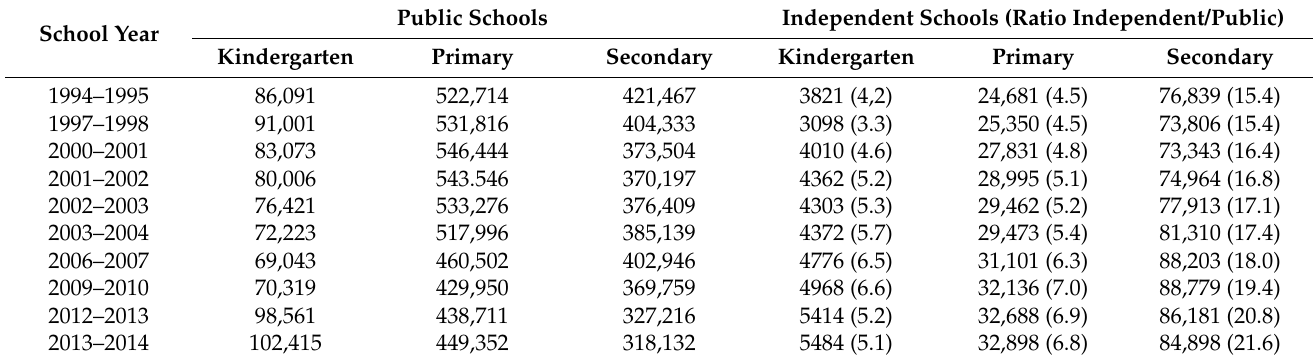
Table A2. Number of students by school level and type, selected years 1994–1995 to 2013–2014, Qu é